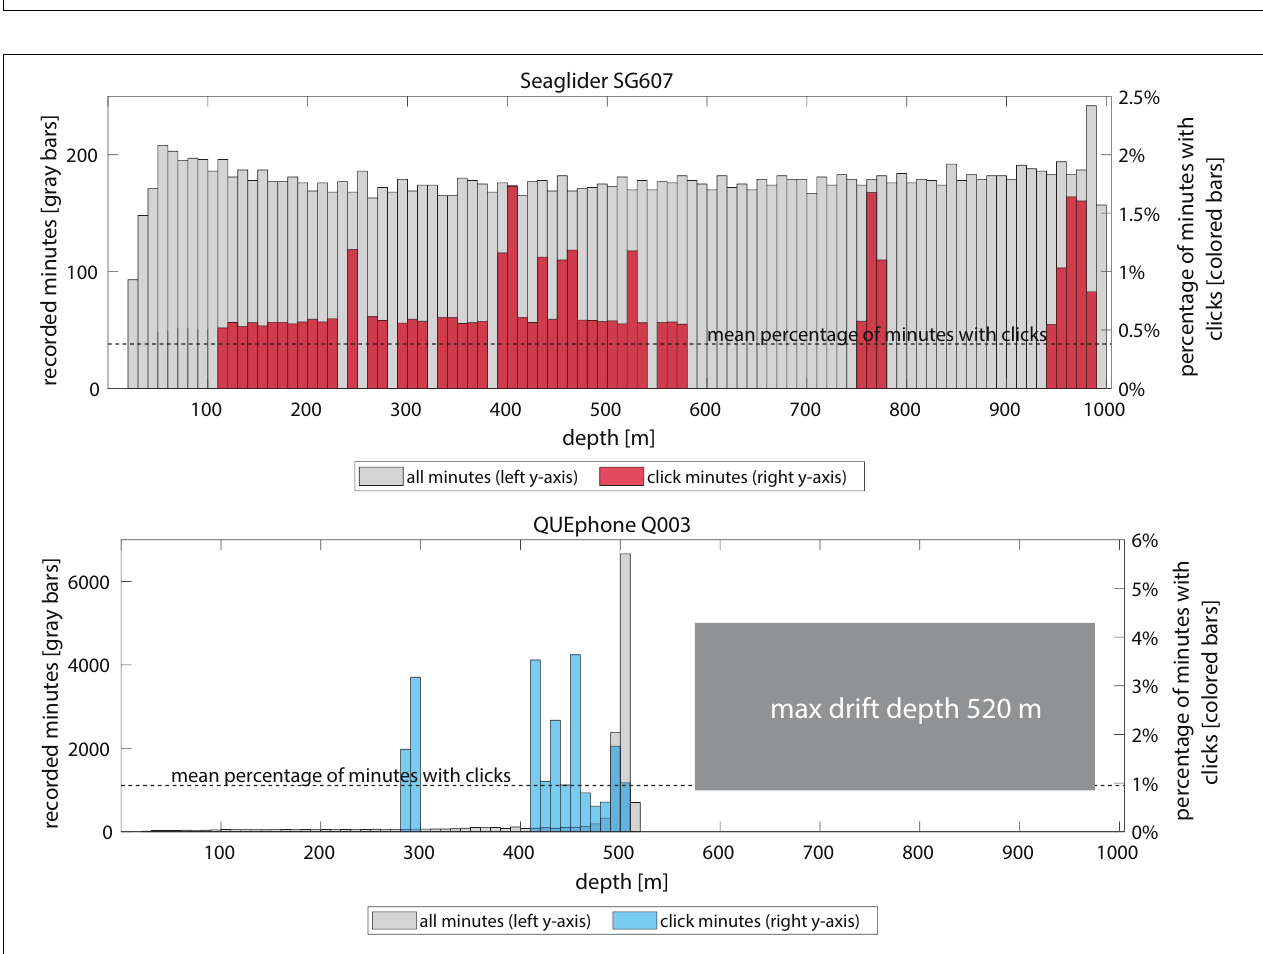
FIGURE 5 | Distribution of mobile platform (Seaglider – top panel , red and QUEphone – bottom panel , blue) depths when Cuvier’s beaked whale clicks were detected. Gray bars and left y -axis indicate total recorded minutes in each 10 m depth bin. Colored bars and right y -axis indicate percentage of recorded minutes in that depth bin that contained Cuvier’s beaked whale clicks. Mean percentage of minutes with clicks across all depths is indicated by the dotted line. Q003’s maximum depth was 520 m; it typically drifted between 480 and 520 m.